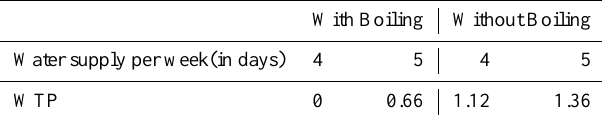
Table 5. Mean WTP per month per household in